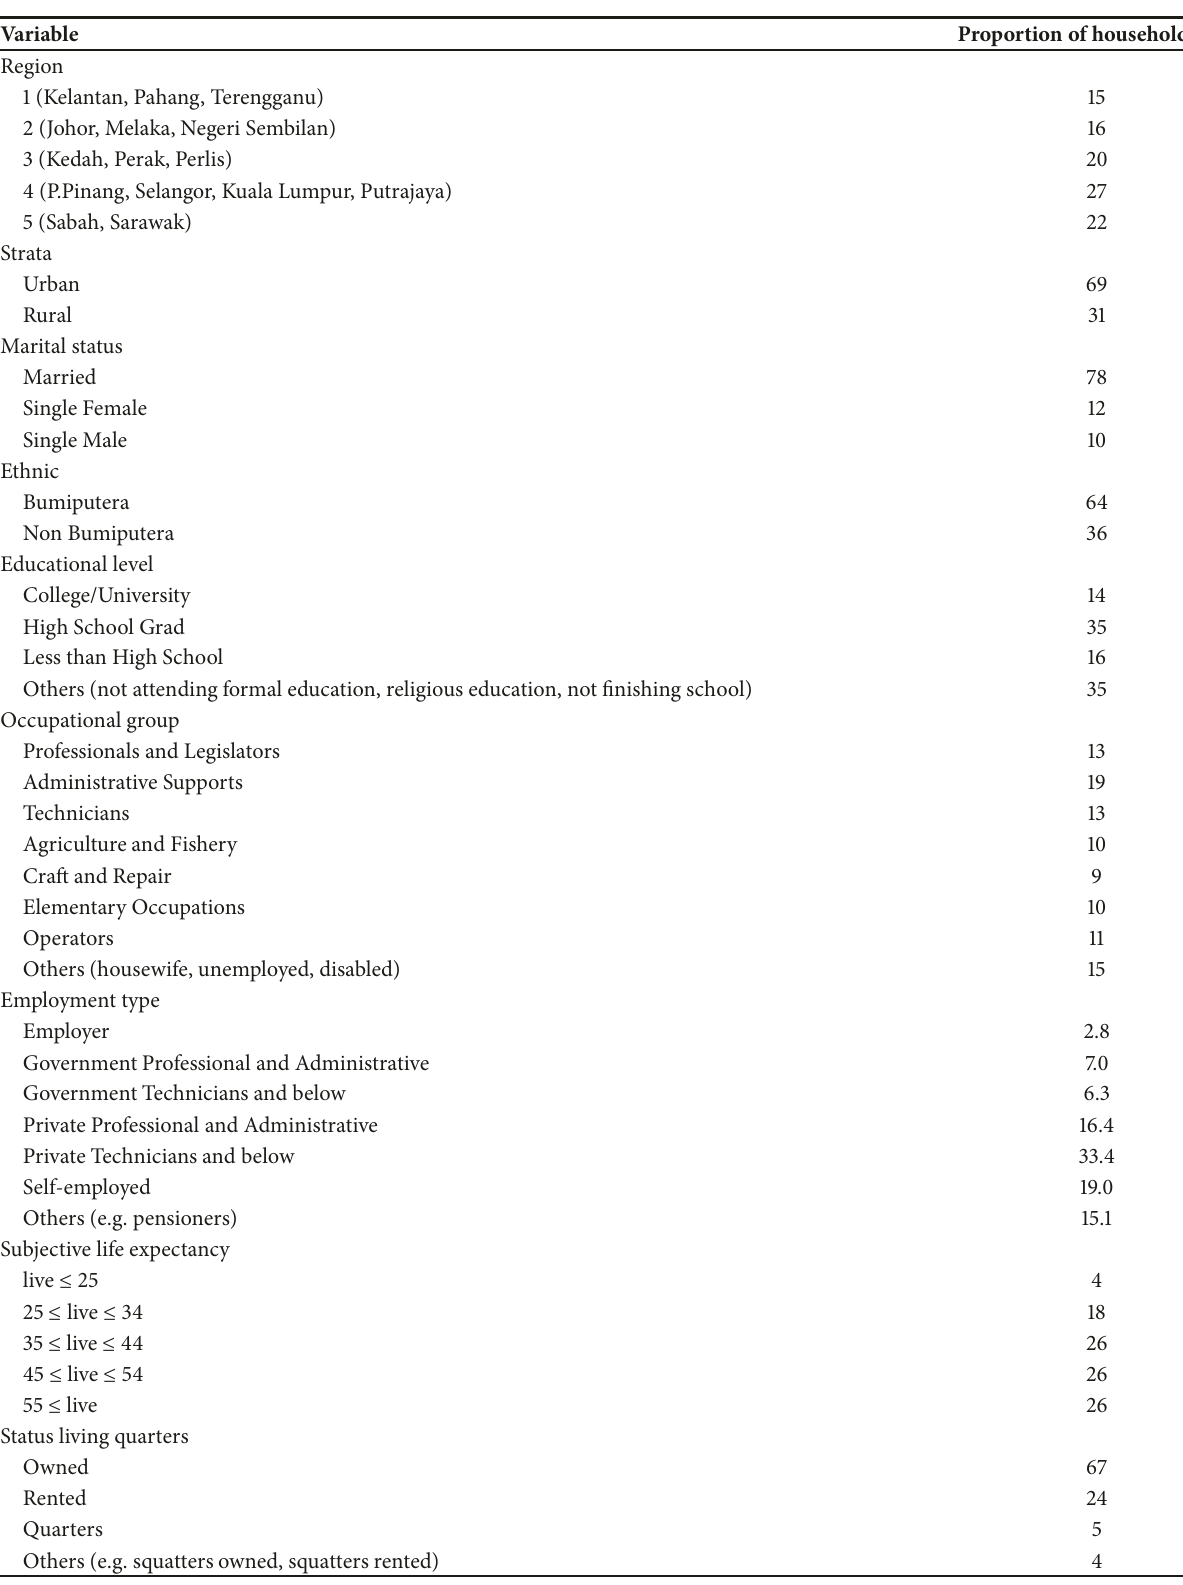
Table 1: Summary statistics for HES Sample